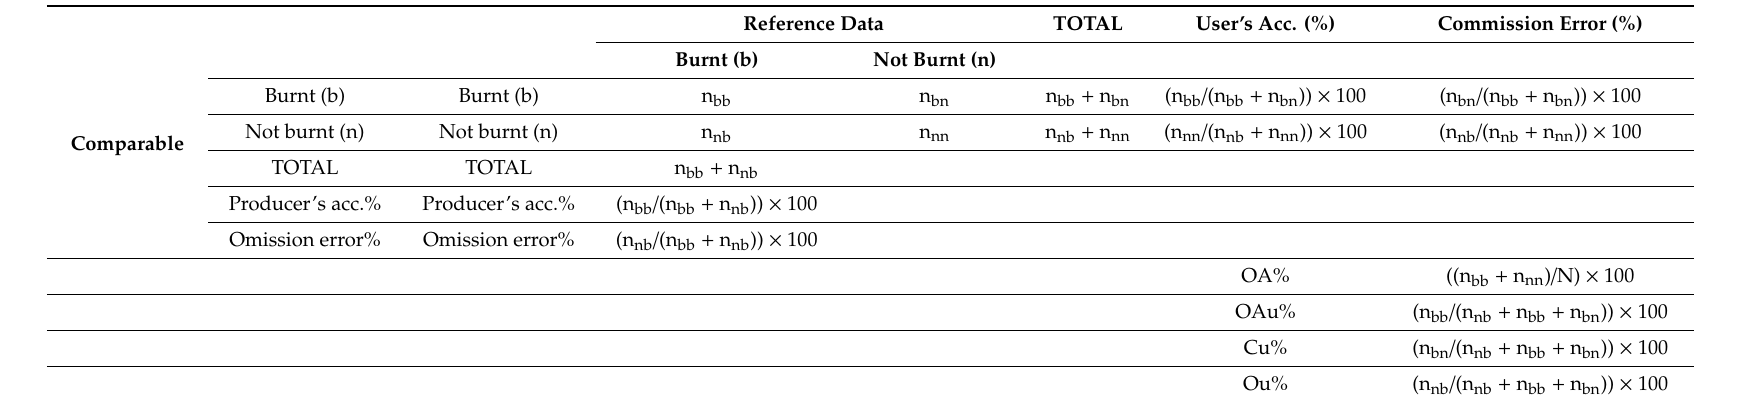
Table 3. Validation template used in the validation of di ff erent comparable data against reference burnt area